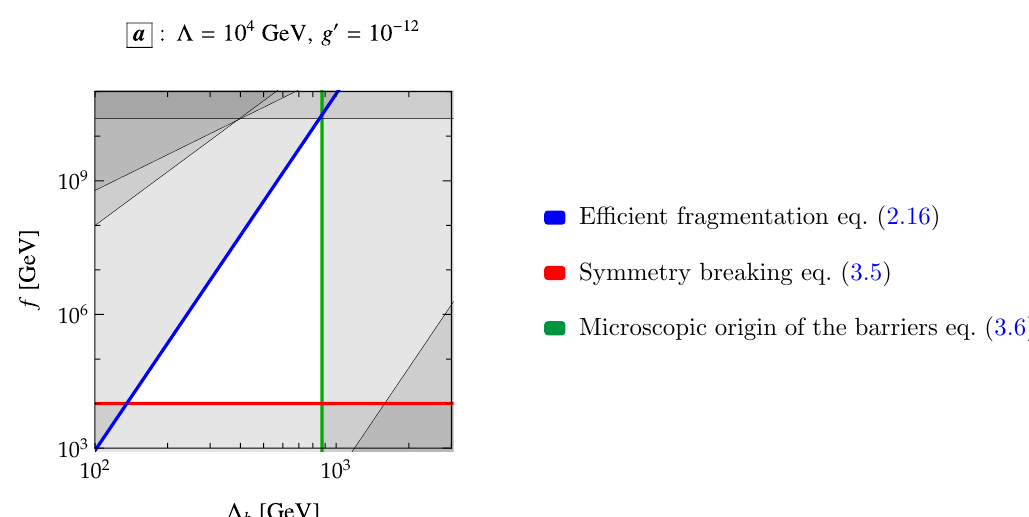
Figure 19 . Same as (cid:12)gure 18 (fragmentation during in(cid:13)ation) but in the ((cid:3) b , f ) plane.